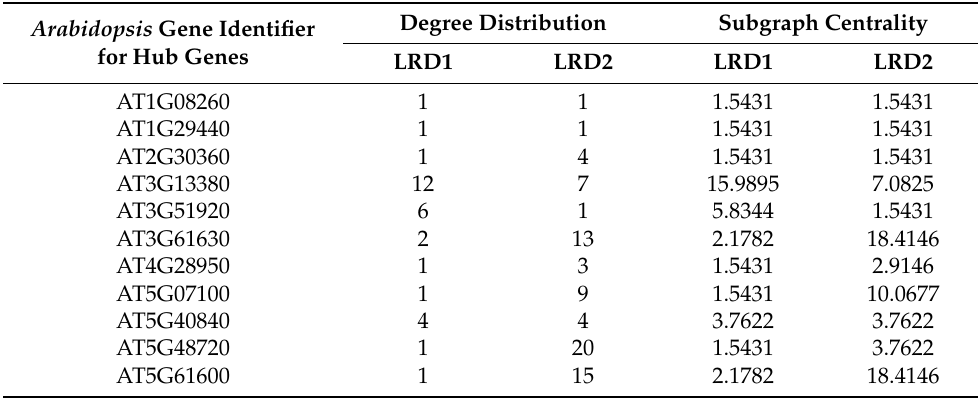
Table 1. Network measures for hub genes in the subnetworks for the cellular response to stimulus process under low radiation